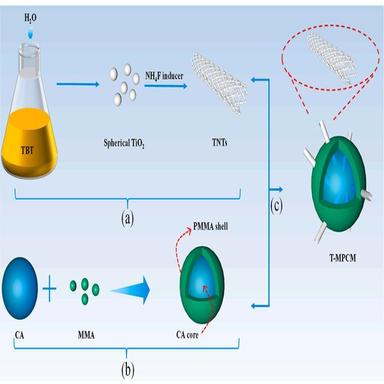
The experimental schematic diagram of prepared T-MPCM.